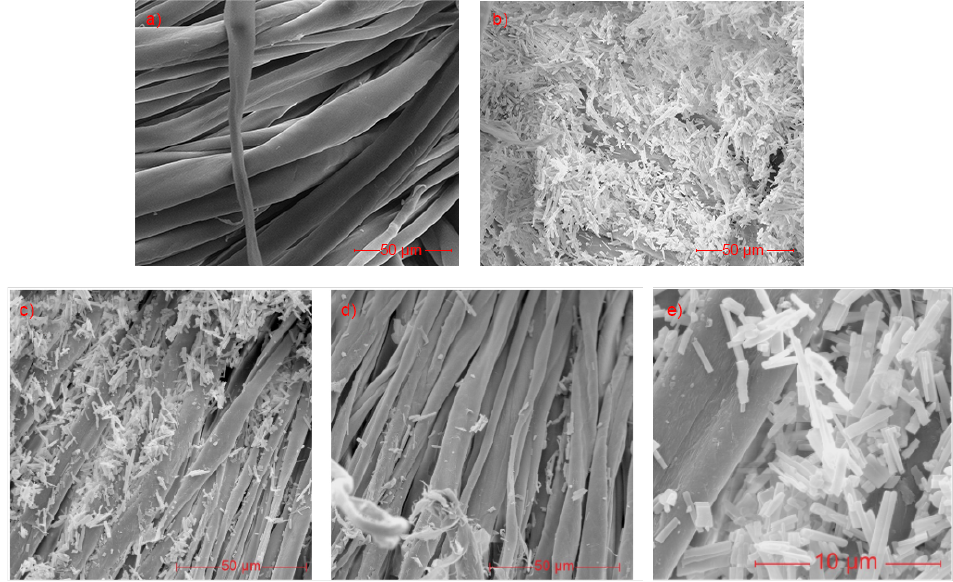
Figure 1. SEM images: ( a ) cotton untreated, ( b ) HKUST-1 nanorods, ( c ) cotton treated before washing and ( d ) after washing. ( e ) Highlight to HKUST-1 nanorods on the cotton.